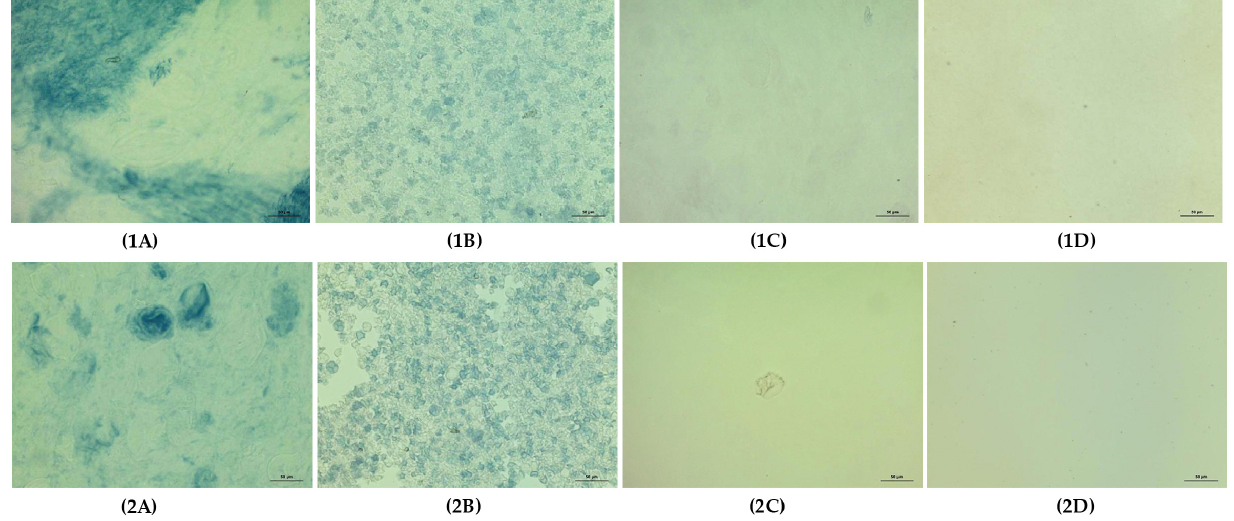
Figure 7. Microstructure of starch gels (Low-shear preparation) (20 × , bar = 50 µ m). Uppercase letters indicate type of starches: ( A ): TS, ( B ): RS, ( C ): WTS, and ( D ): WRS. The number indicate the system used to prepare starch gels; ( 1 ): neutral system and ( 2 ): sugar–acid system. ( 1A ): TS gel in a neutral system; ( 1B ): RS gel in a neutral system; ( 1C ): WTS gel in a neutral system; ( 1D ): WRS gel in a neutral system; ( 2A ): TS gel in a sugar-acid system; ( 2B ): RS gel in a sugar-acid system; ( 2C ): WTS gel in a sugar-acid system; ( 2D ): WRS gel in a sugar-acid